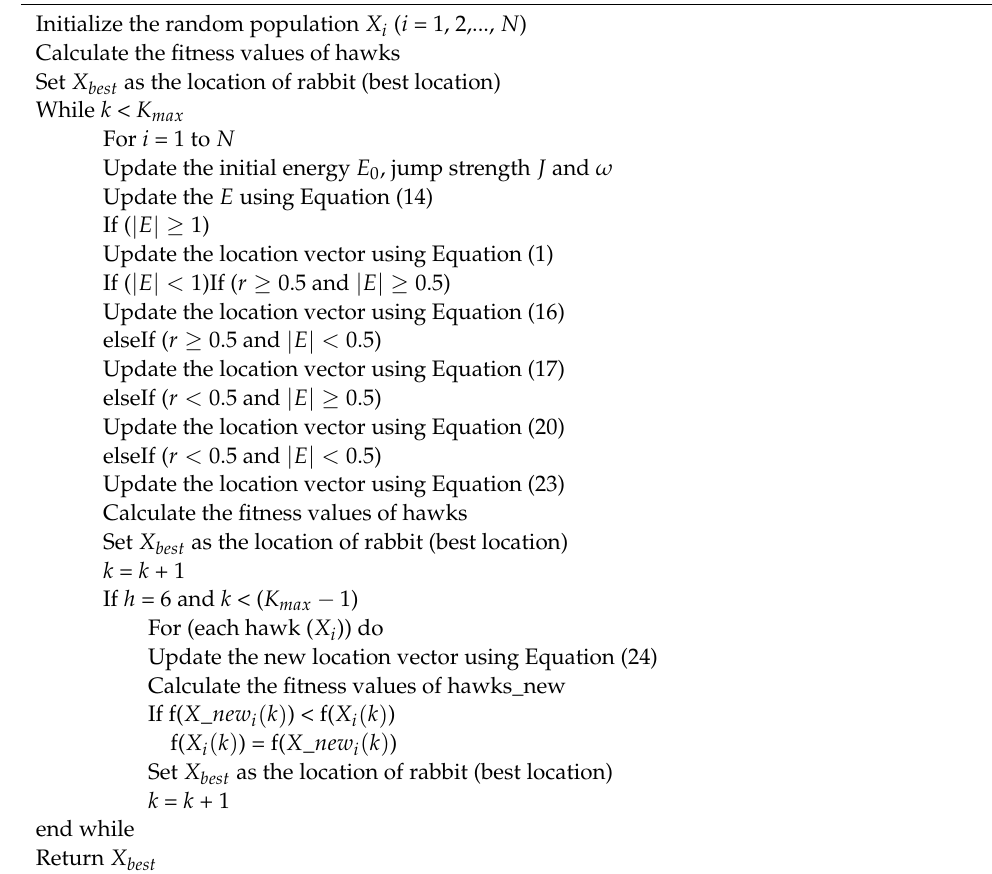
Algorithm 2 The ARHHO